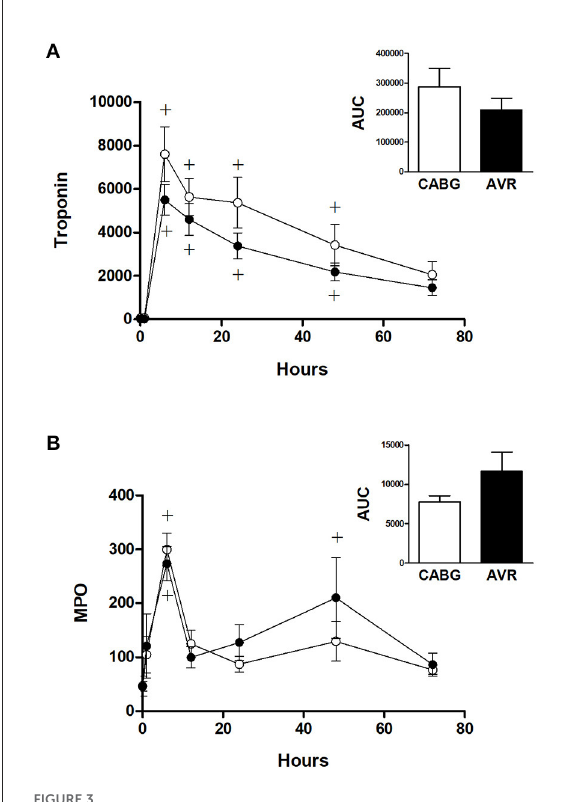
FIGURE4 Cardiac injury and oxidative stress in diabetic and non-diabetic CABG patients. Values are mean ± SEM for ’levels of (A) troponin I (ng/L) and (B) MPO (ng/ml) in patients undergoing CABG surgery who are non-diabetic (ND, white) or diabetic (D, black). No significant differences were revealed by two-way mixed model ANOVA. One-way ANOVAs with post-hoc Dunnett’s test where appropriate were also performed individually for each surgery type; + represents a significant difference compared to basal levels. No statistical significance was found for the AUC (area under the curve) analyses (unpaired two-tailed student’s t -test or Mann-Whitney U -test as